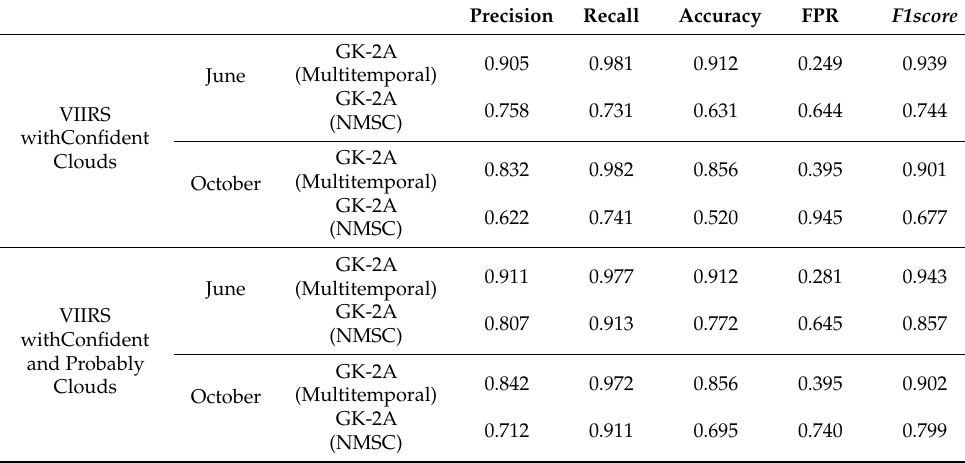
Table 2. Quantitative validation results between GK-2A and VIIRS cloud mask products. Precision Recall Accuracy FPR